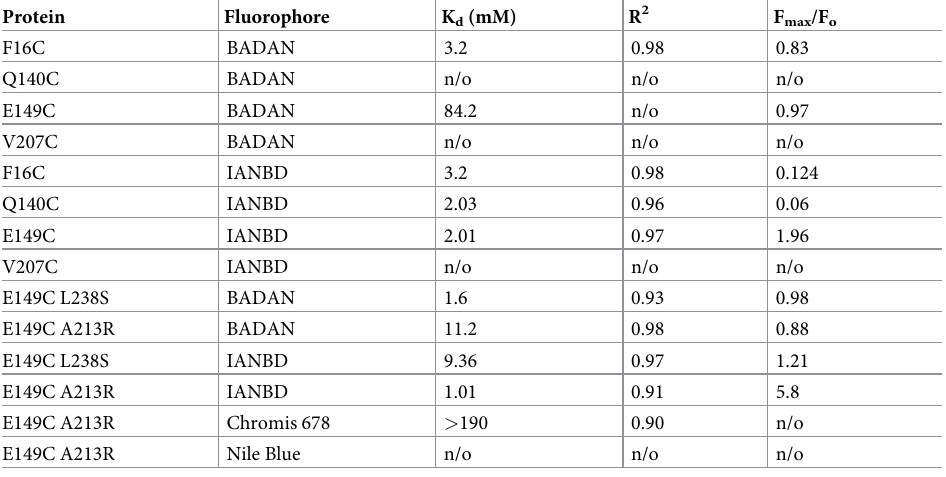
Table 3. Summary of the biochemical characteristics of GBP-labelled mutants. Protein Fluorophore